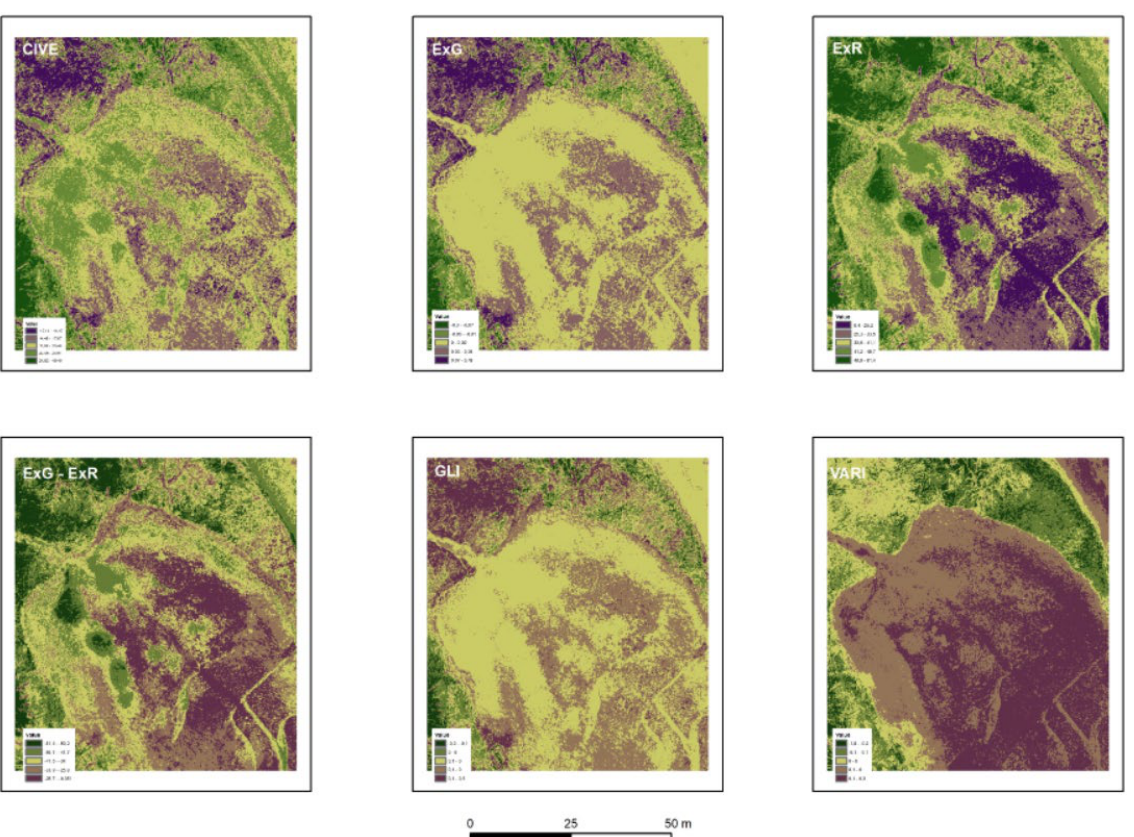
Figure 4. Spectral indices for the area on March 8, 2018, after low pass filtering